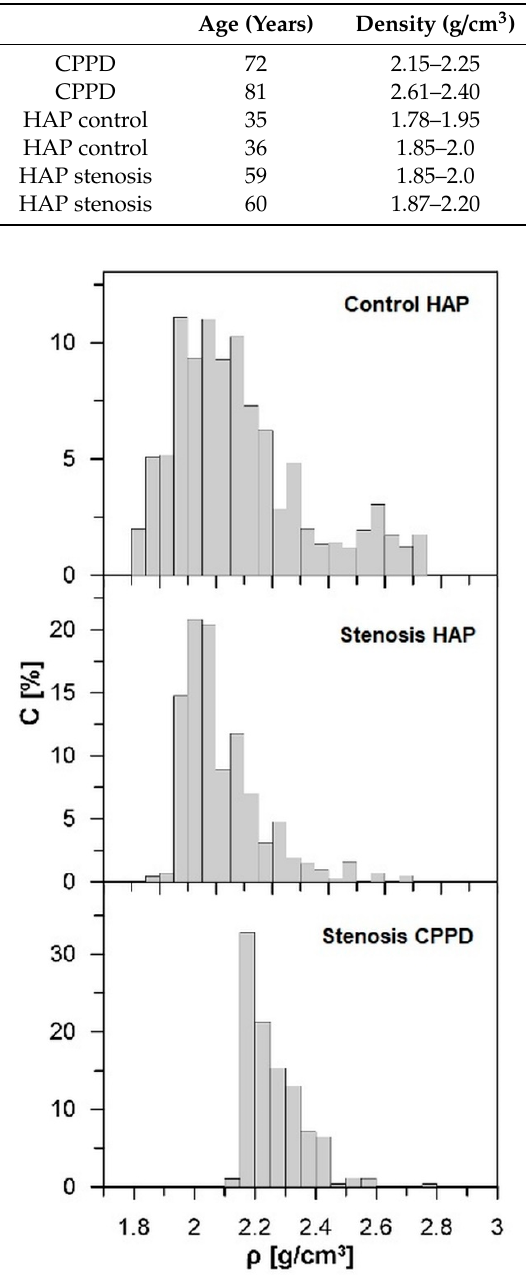
Figure 4. Histogram of grains density distribution ( ρ ) in ligamentum flavum samples. C—percentage contribution of minerals with given density in 100 mm 3 of a sample [30].